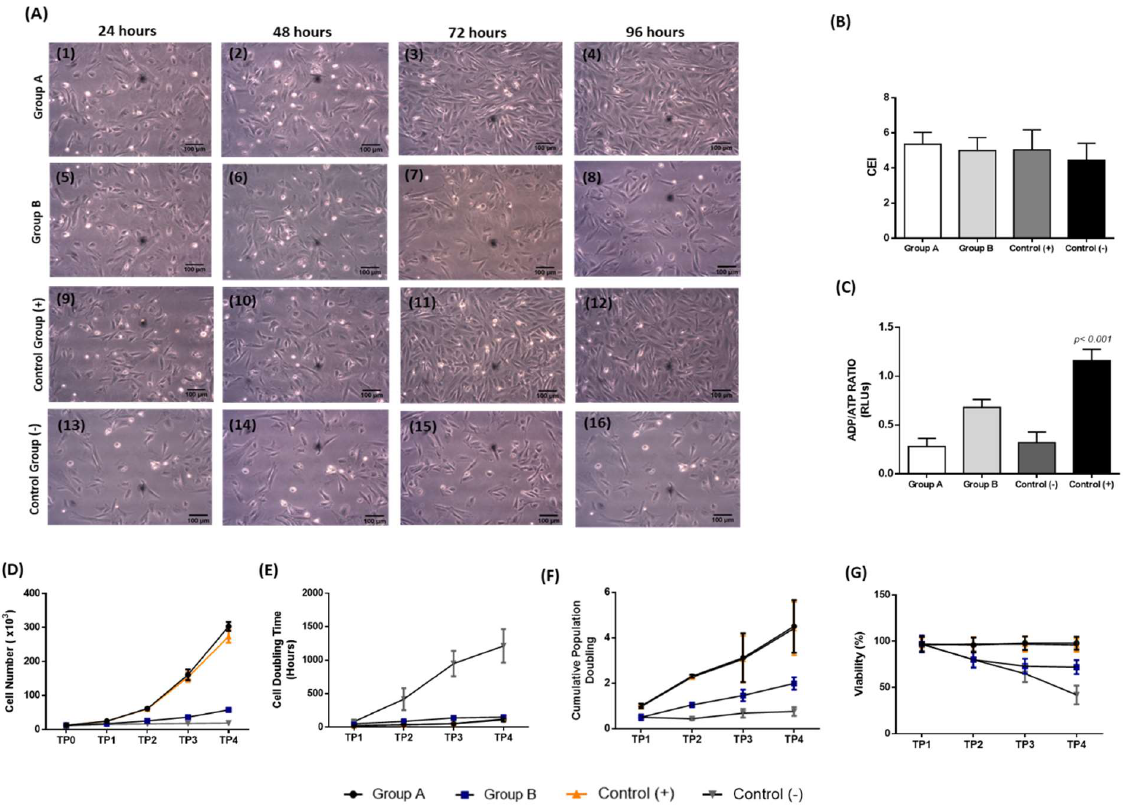
Figure 2. Evaluation of CEC characteristics utilizing different experimental approaches. ( A ) Mor- phological features of the CECs of group A (A1–A4), ( B ) (A5–A8), positive control group (A9–A12), and negative control group (A13–A16). CECs of group A and positive control group were culture expanded and proliferated well until confluence was observed after 96 h. CECs of group B and negative control group did not proliferate with the same rate compared to the above groups and eventually no confluence was observed after 96 h. All images acquired with original magnification 10x and scale bars 100 μm. Evaluation of the CEI ( B ) and ADP/ATP ratio ( C ) of CECs. Evaluation of quality characteristics of CECs, including cell number ( D ), CDT ( E ), CPD ( F ), and viability ( G ). CECs of group A and positive control group characterized by better expansion and proliferation proper- ties compared to those of group B and negative control group. Statistically significant differences were observed in ADP/ATP ratio ( p < 0.001), cell number ( p < 0.001), CDT ( p < 0.05), cumulative PD ( p < 0.05) and viability ( p < 0.001), between all groups. Group A: CECs cultured with α-ΜΕΜ sup- plemented with 20% v/v CB-PL), Group B: CECs cultured with α-ΜΕΜ supplemented with 20% v/v CB-PPP, Control group (+): Positive control group, CECs cultured with complete culture medium, Control group (−), negative control group: CECs cultured only with α-MEM.